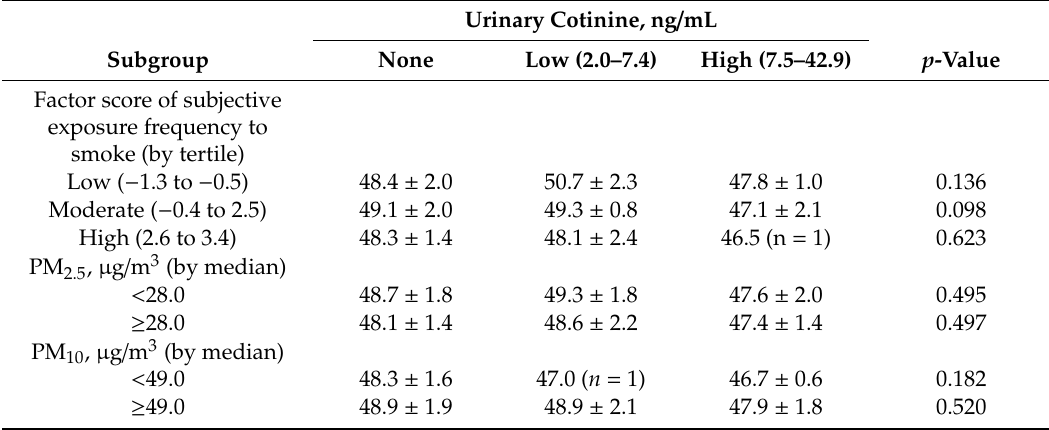
Table 3. Newborn’s length on subgroup analysis by urinary cotinine level and subjective frequency of exposure to smoke / air pollution ( N = 74).